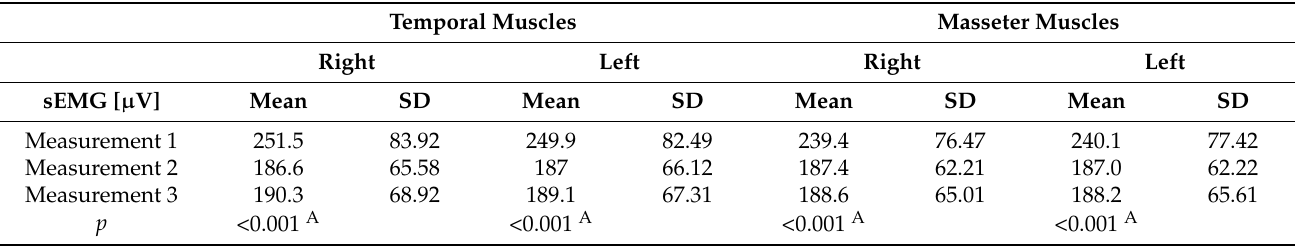
Table 4. Mean values of electric potentials [ µ V] of the anterior part of temporal muscles and masseter muscles measured during the first examination and control tests in group I.